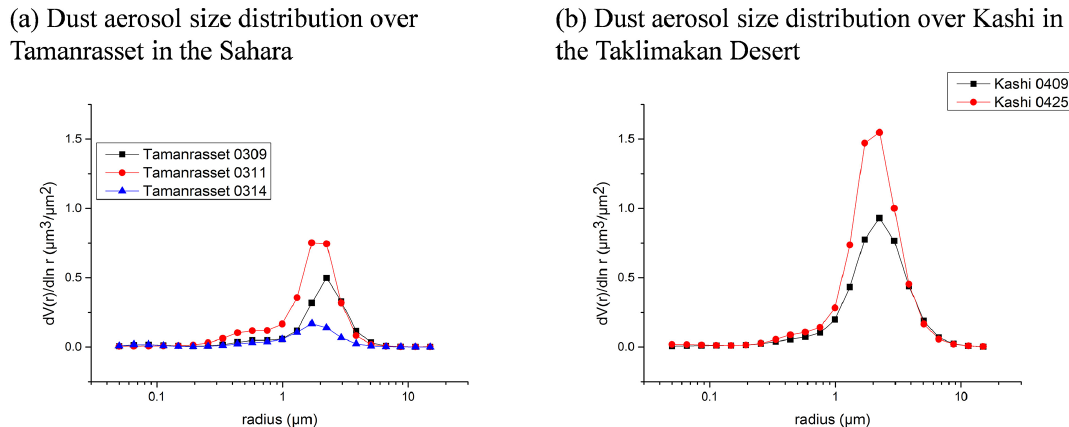
Figure 12. Dust aerosol size distribution over (a) Tamanrasset in the Sahara and (b) Kashi in the Taklimakan Desert.